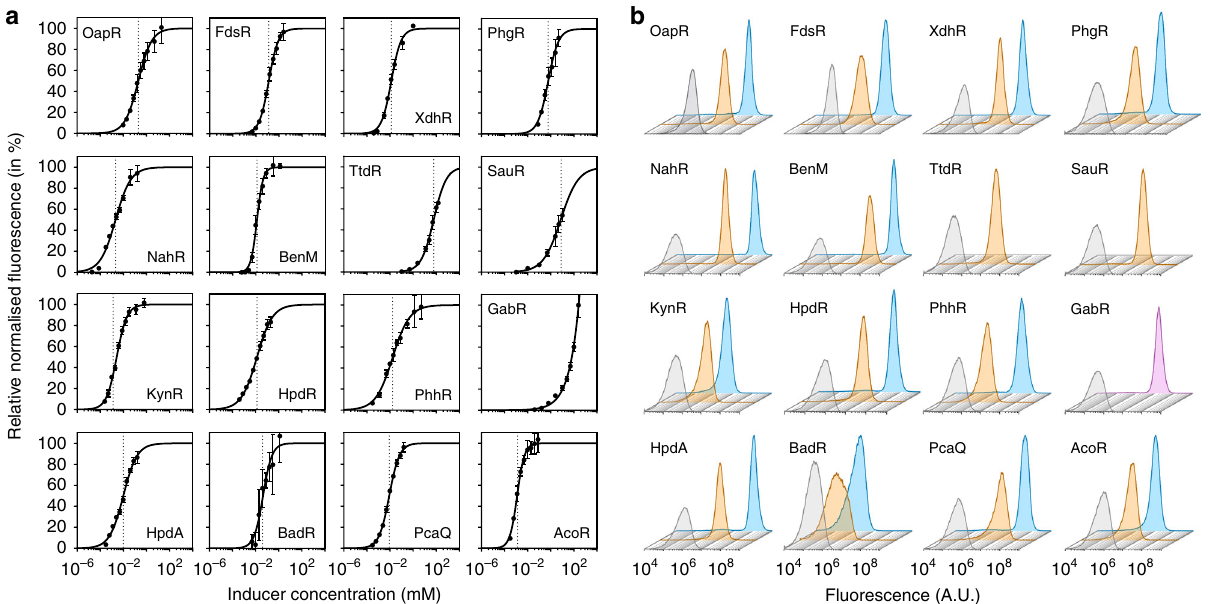
Fig. 5 Response function and induction homogeneity. a Relative normalised fl uorescence of C. necator carrying the various inducible system – reporter constructs in response to different concentrations of their corresponding primary inducers. Measurements were taken 80 min after the inducer had been extracellularly added. The dose – responses were fi t using a Hill function (see Methods section). The maximum level of reporter output b max was set to 100% (except in case of the GABA-inducible system where the absolute normalised fl uorescence corresponding to the highest GABA concentration tested was set to 100%). The inducer concentration that mediates half-maximal reporter output K m is indicated by a dotted line. Data are mean ± SD, n = 3, non- linear regression. Source data are provided as a Source Data fi le. b Evaluation of induction homogeneity by fl ow cytometry. The fl uorescence intensity of 100,000 individual cells was determined for each inducible system – reporter construct 2 h after extracellular addition of inducer. Uninduced cells (grey) are compared to cultures supplemented with their cognate effector at fi nal concentrations corresponding to 50% (orange) and 95% (blue; 90% in case of the phenylglyoxylate-inducible system) of the maximum level of reporter output b max . The tartrate- and sulfonatoacetate-inducible systems were only evaluated for induction homogeneity at 50% of b max due to solubility limits and inducer toxicity, respectively. Since b max could not be calculated for the GABA-inducible system, induction homogeneity was determined using a fi nal concentration of 250 mM (purple).